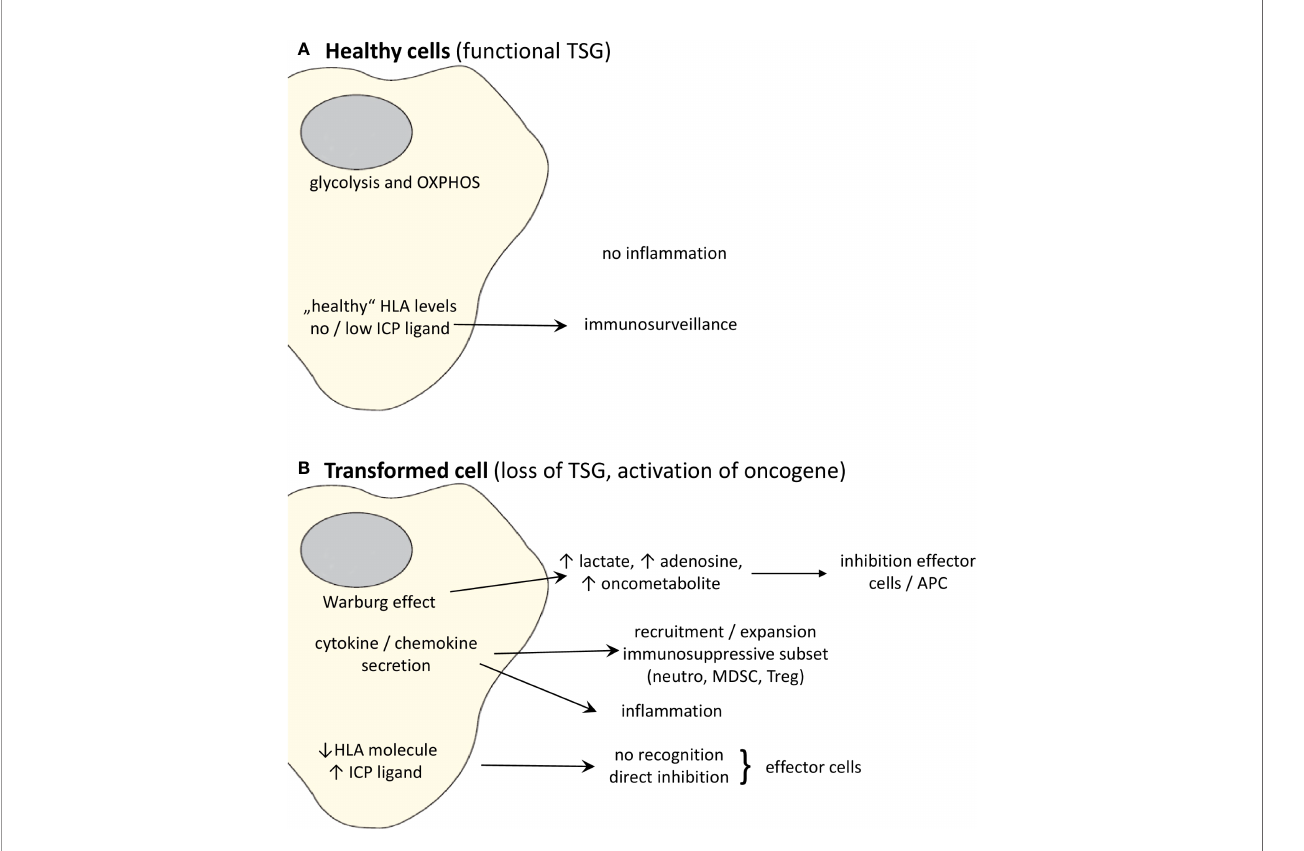
FIGURE 1 | Effects of oncogenic activation and inactivation of TSG on the immune system. (A) Whereas “ healthy ” cells expressing non-mutated, functional TSG can be recognized by the immune system, (B) transformation to malignant cells due to activation of oncogenes and/or loss of TSGs changes the cell metabolism and cytokine/chemokine secretion pattern leading to the promotion of an immunosuppressive TME. Moreover, the altered oncogene and TSG expression causes a downregulation or loss of the expression of HLA class I molecules and upregulation of ligands for ICP leading to a direct escape from recognition by effector